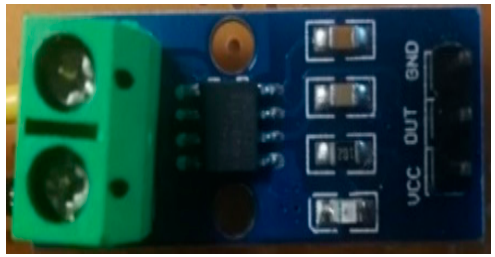
Figure 8. Current sensor.